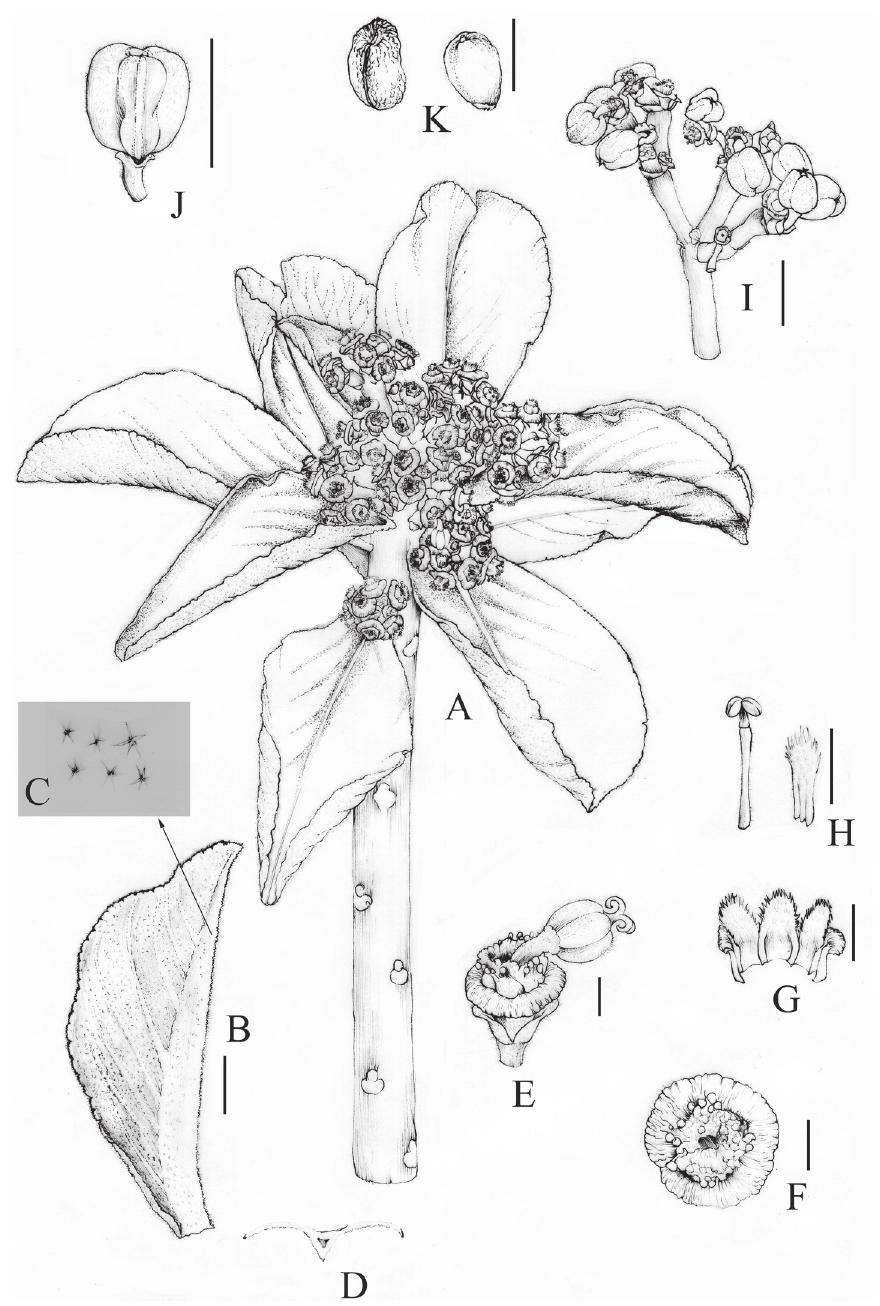
Figure 2. Euphorbia mbuinzauensis A flowering branch B leaf C the close-up of abaxial leaf to show densely stellate hairs D section through leaf to show the distinct keel on midrib beneath E cyathium, lateral view F cy- athium, top view G dissected involucre to show lobes H male flower and bracteole I infructescence J fruit. K. Seeds. Scale bars: 2 mm ( C–H, K ); 1 cm ( B, I, J ). Voucher specimen: SAJIT 007200 . Drawn by Nan